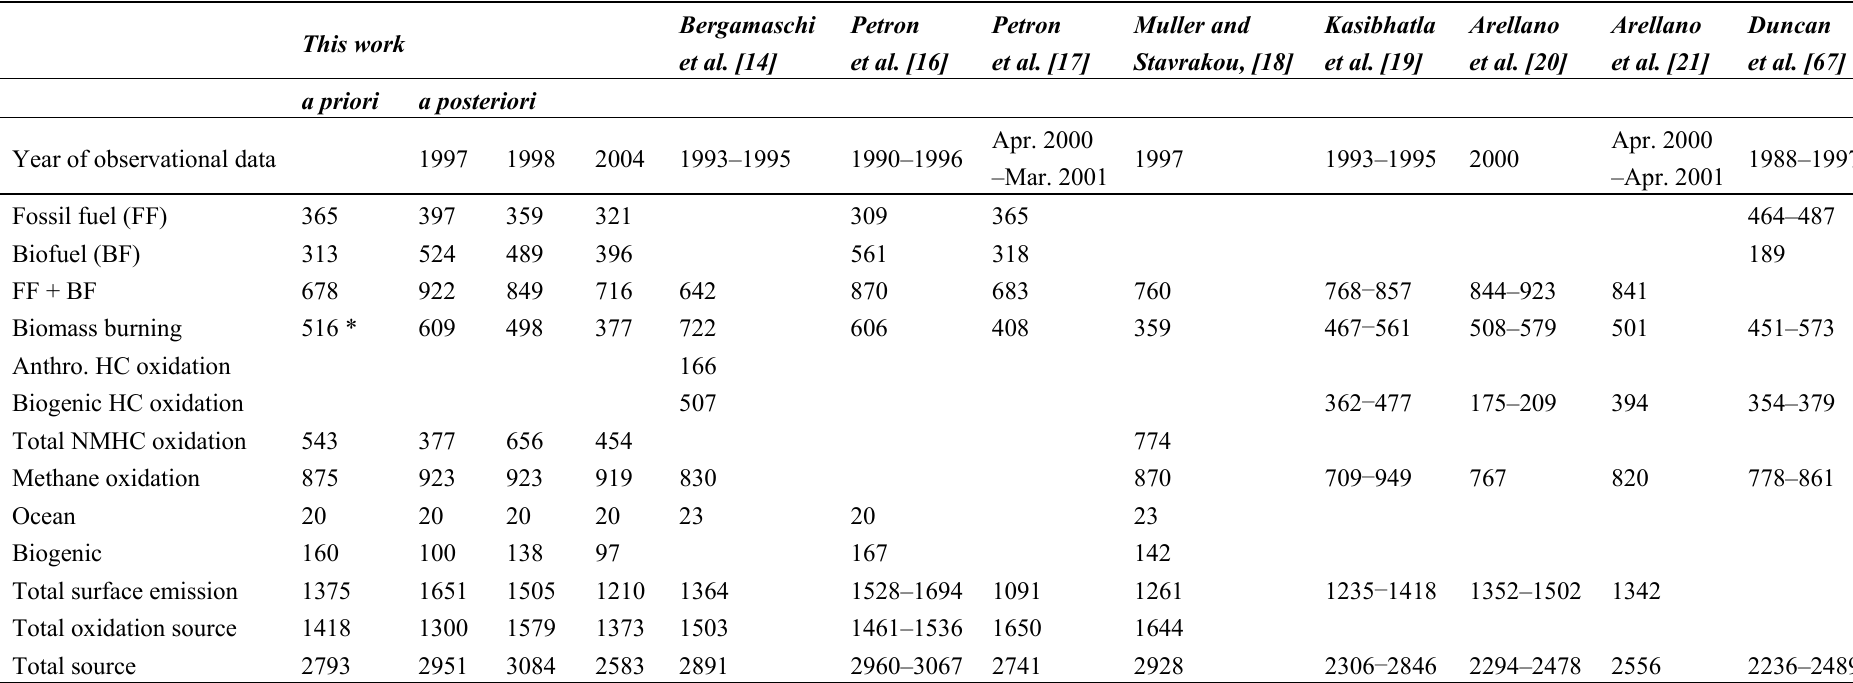
Table 4. The results of global CO budget estimation (this work) in comparison to previous global CO budget